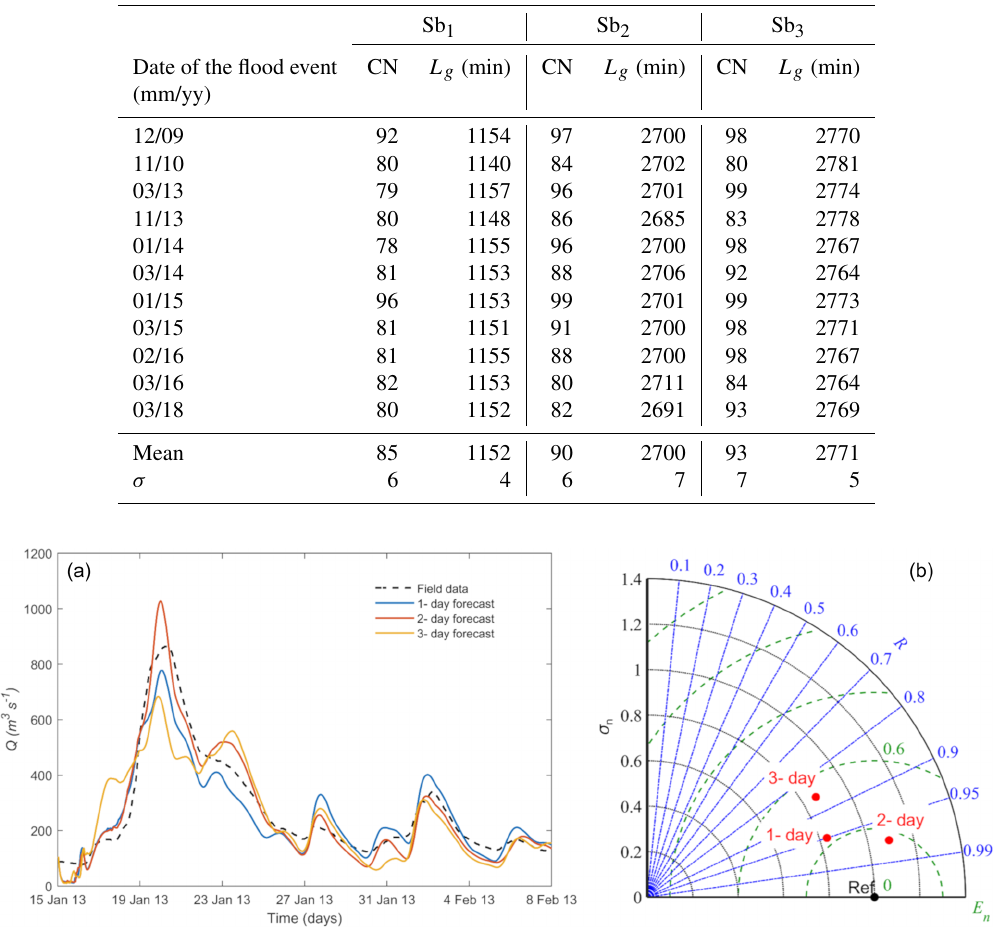
Figure 4. Time series of the outflow at the control point obtained in the gauge station (dashed line) and calculated using the three forecast windows (a) and Taylor diagram for the same cases (b) .